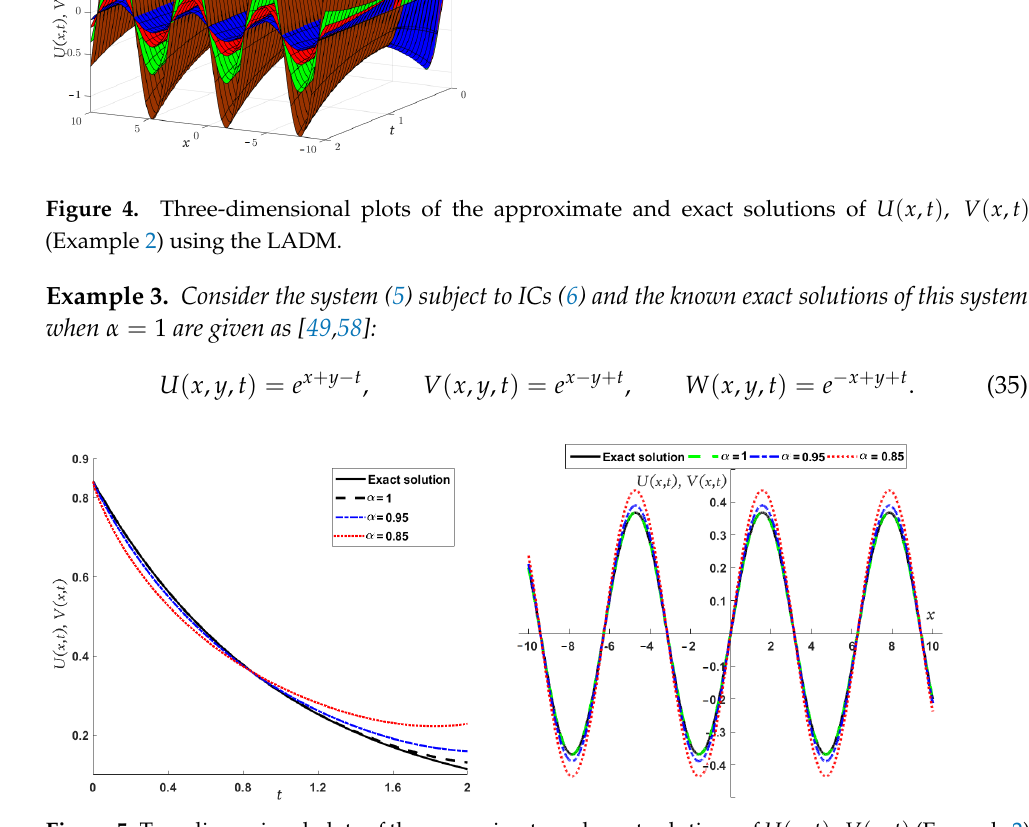
Figure 5. Two-dimensional plots of the approximate and exact solutions of U ( x , t ) , V ( x , t ) (Example 2) using the LADM, when x = 1 ( right figure) and t = 1 ( left